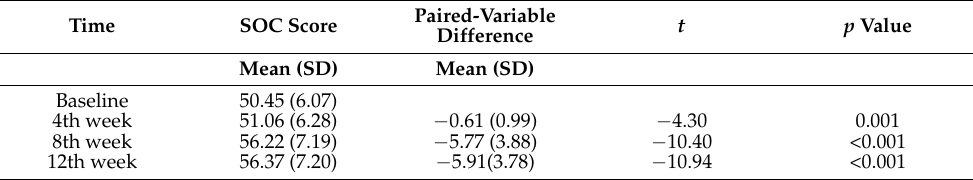
Table 2. Sense of coherence score of the experimental group ( n = 49) before and after intervention.